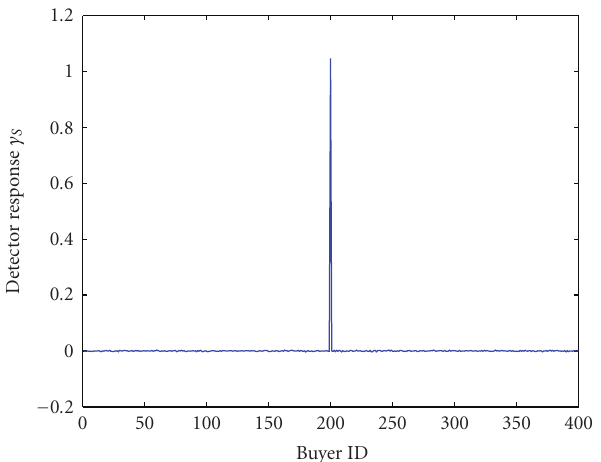
Figure 2: Identifying the “honest” buyer by the seller. The seller tests the buyers with the watermark V according to (3).